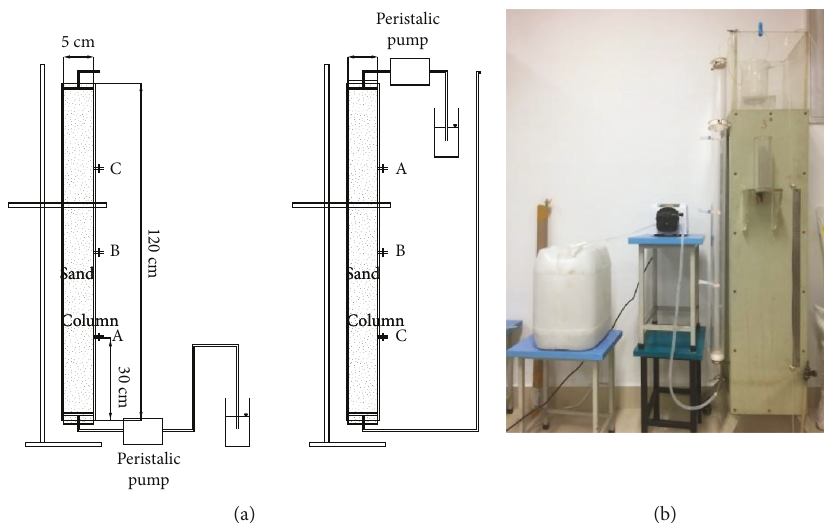
Figure 2: Schematic diagram and physical map of the test model: (a) schematic diagram and (b) physical